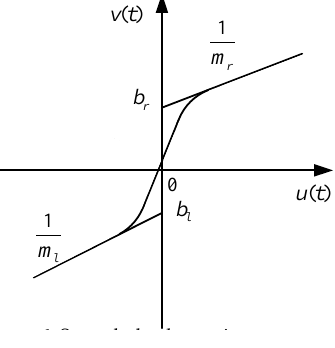
. Smooth dead-zone inversion is shown in Figure 6: